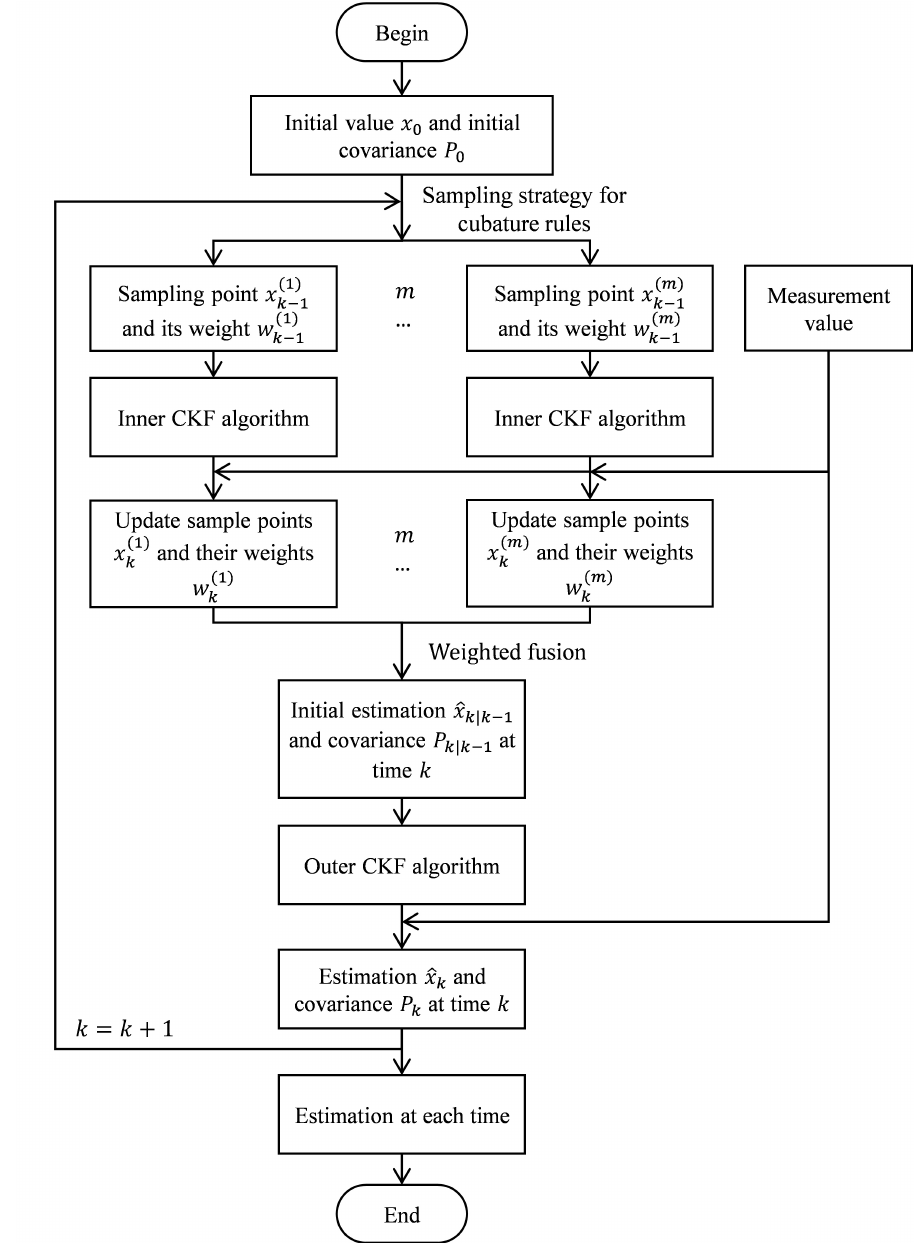
Figure 1. The flowsheet of